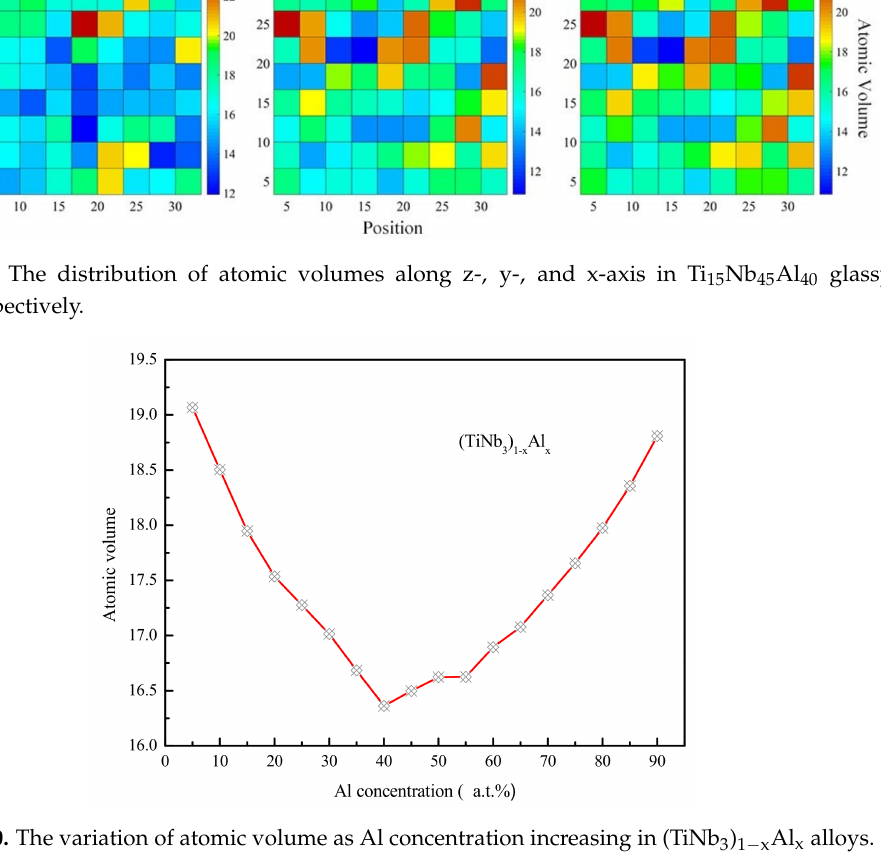
Figure 10. The variation of atomic volume as Al concentration increasing in (TiNb 3 ) 1 − x Al x